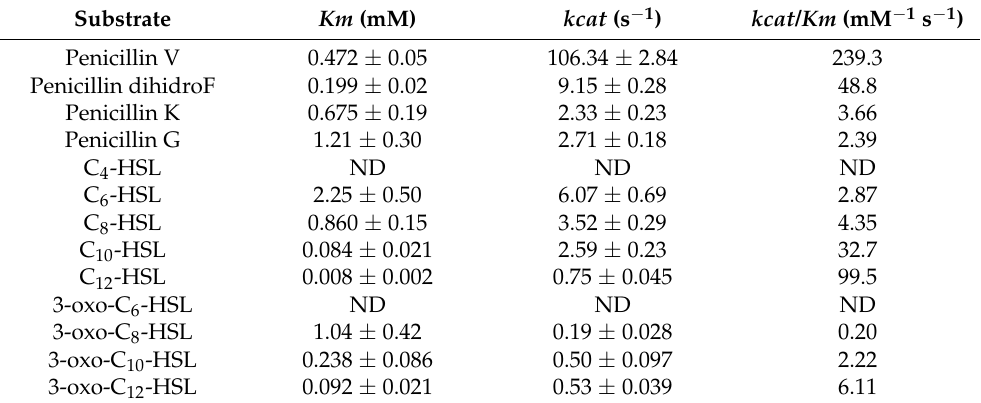
Table 1. Kinetic parameters of AuAHLA using different natural penicillins and AHLs as substrate. Substrate Km